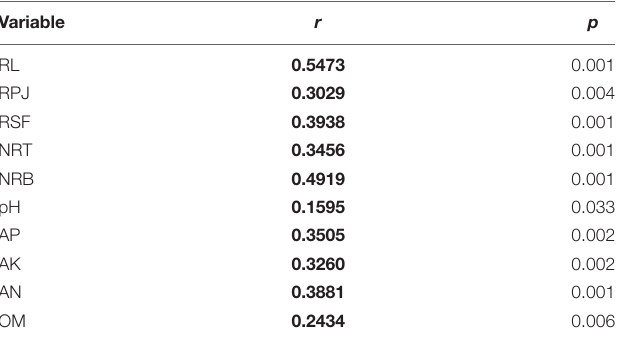
TABLE 4 | Spearman’s correlation of environmental variables with bacterial community structure as determined by the Mantel test.